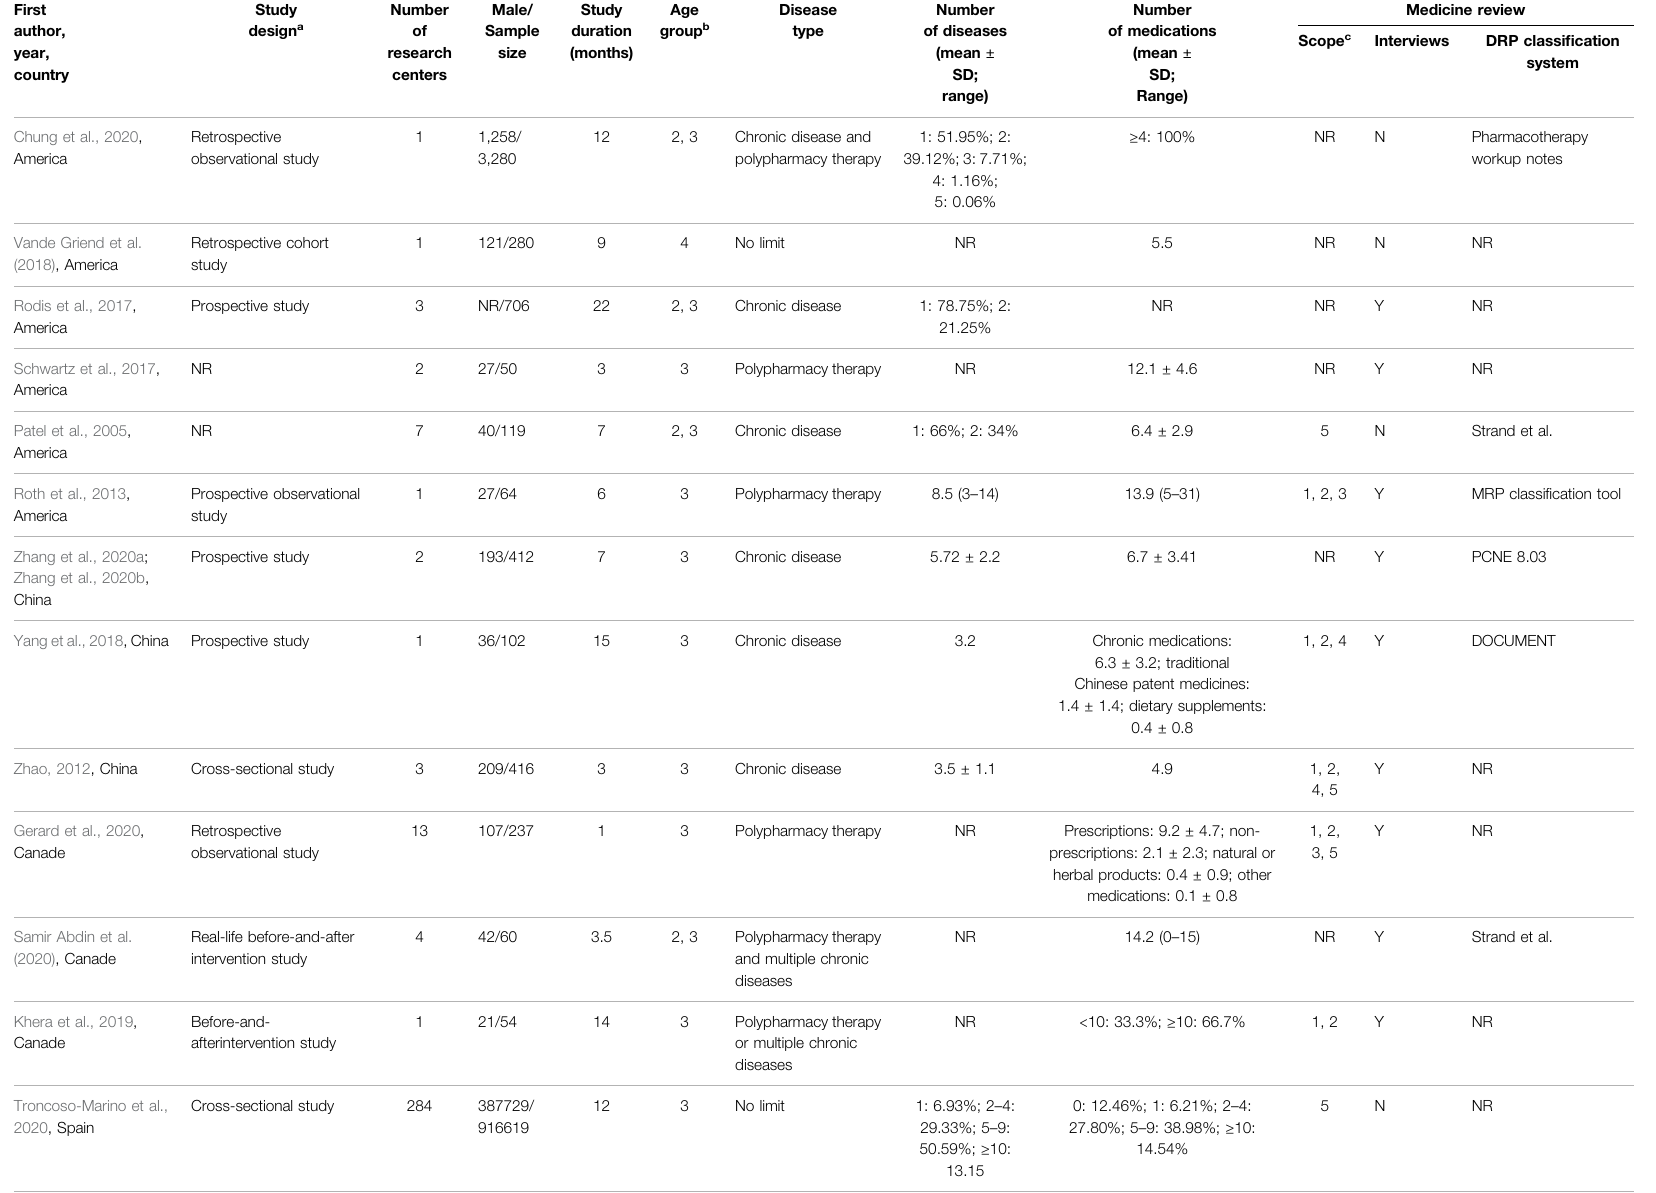
TABLE 2 | The information of the study characteristics and study